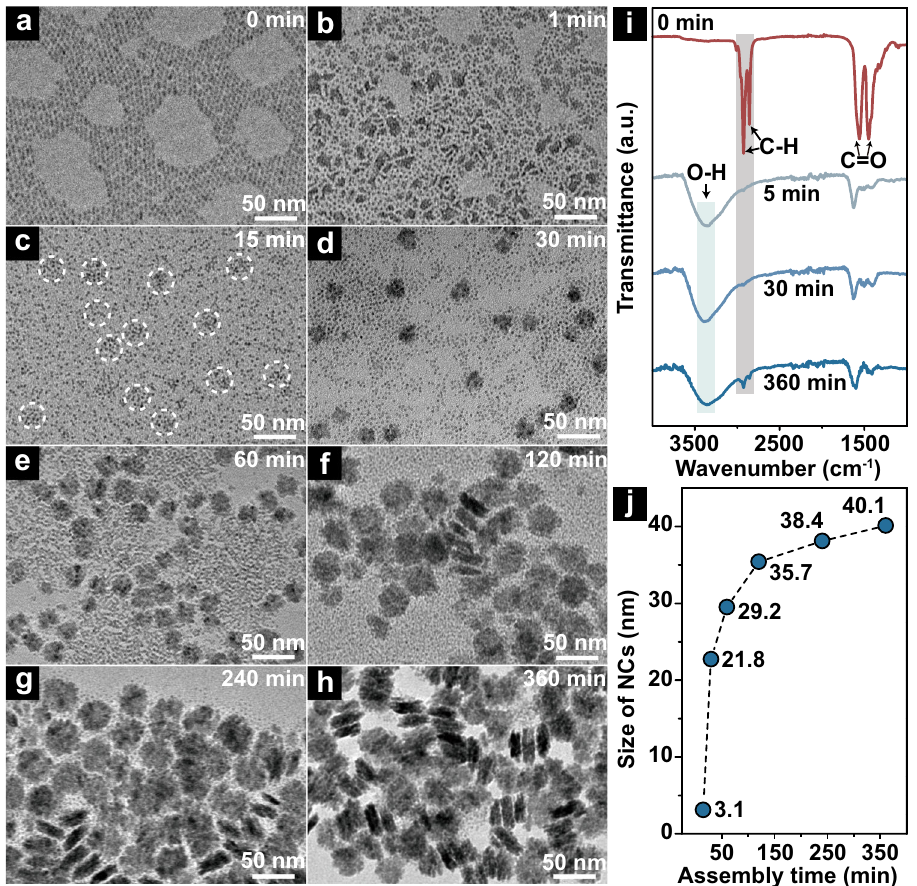
Fig. 2 Different assembly stages of NCs. TEM images of the products obtained at assembly time of a 0, b 1, c 15, d 30, e 60, f 120, g 240, and h 360 min, respectively. i FT-IR spectra of the products obtained at the assembly time of 0, 5, 30, and 360 min, respectively. j Time-dependent size evolution of NCs. White dotted-circles in c show the NCs formed at very early (Fig. 4a – c). Similarly, core-shelled NCs of EuF 3 @GdF 3 and